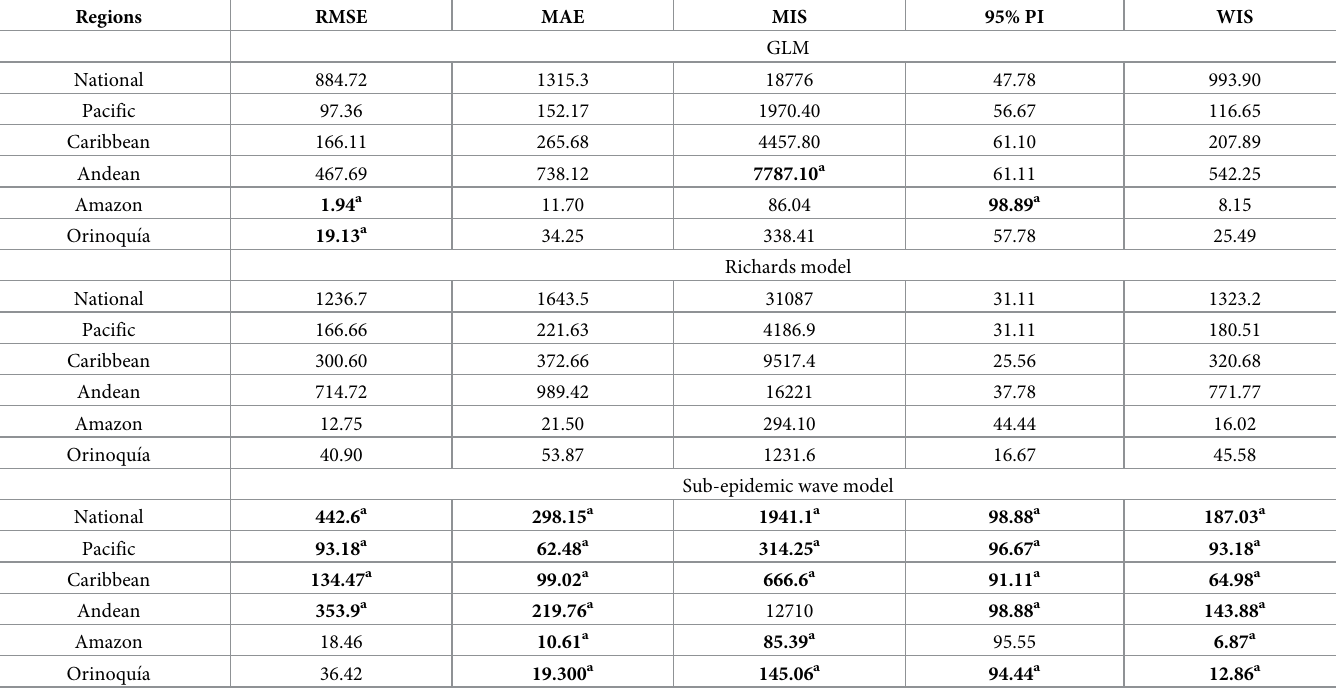
Table 2. Comparison of model performance metrics by calibrating the GLM, Richards and the sub-epidemic model for 90 epidemic days (July 4, 2021 to October 1, 2021) at the national and regional level. Higher 95% PI coverage and lower RMSE, MAE, WIS and MIS represent better performance. Best performing model is given in bold with the superscript